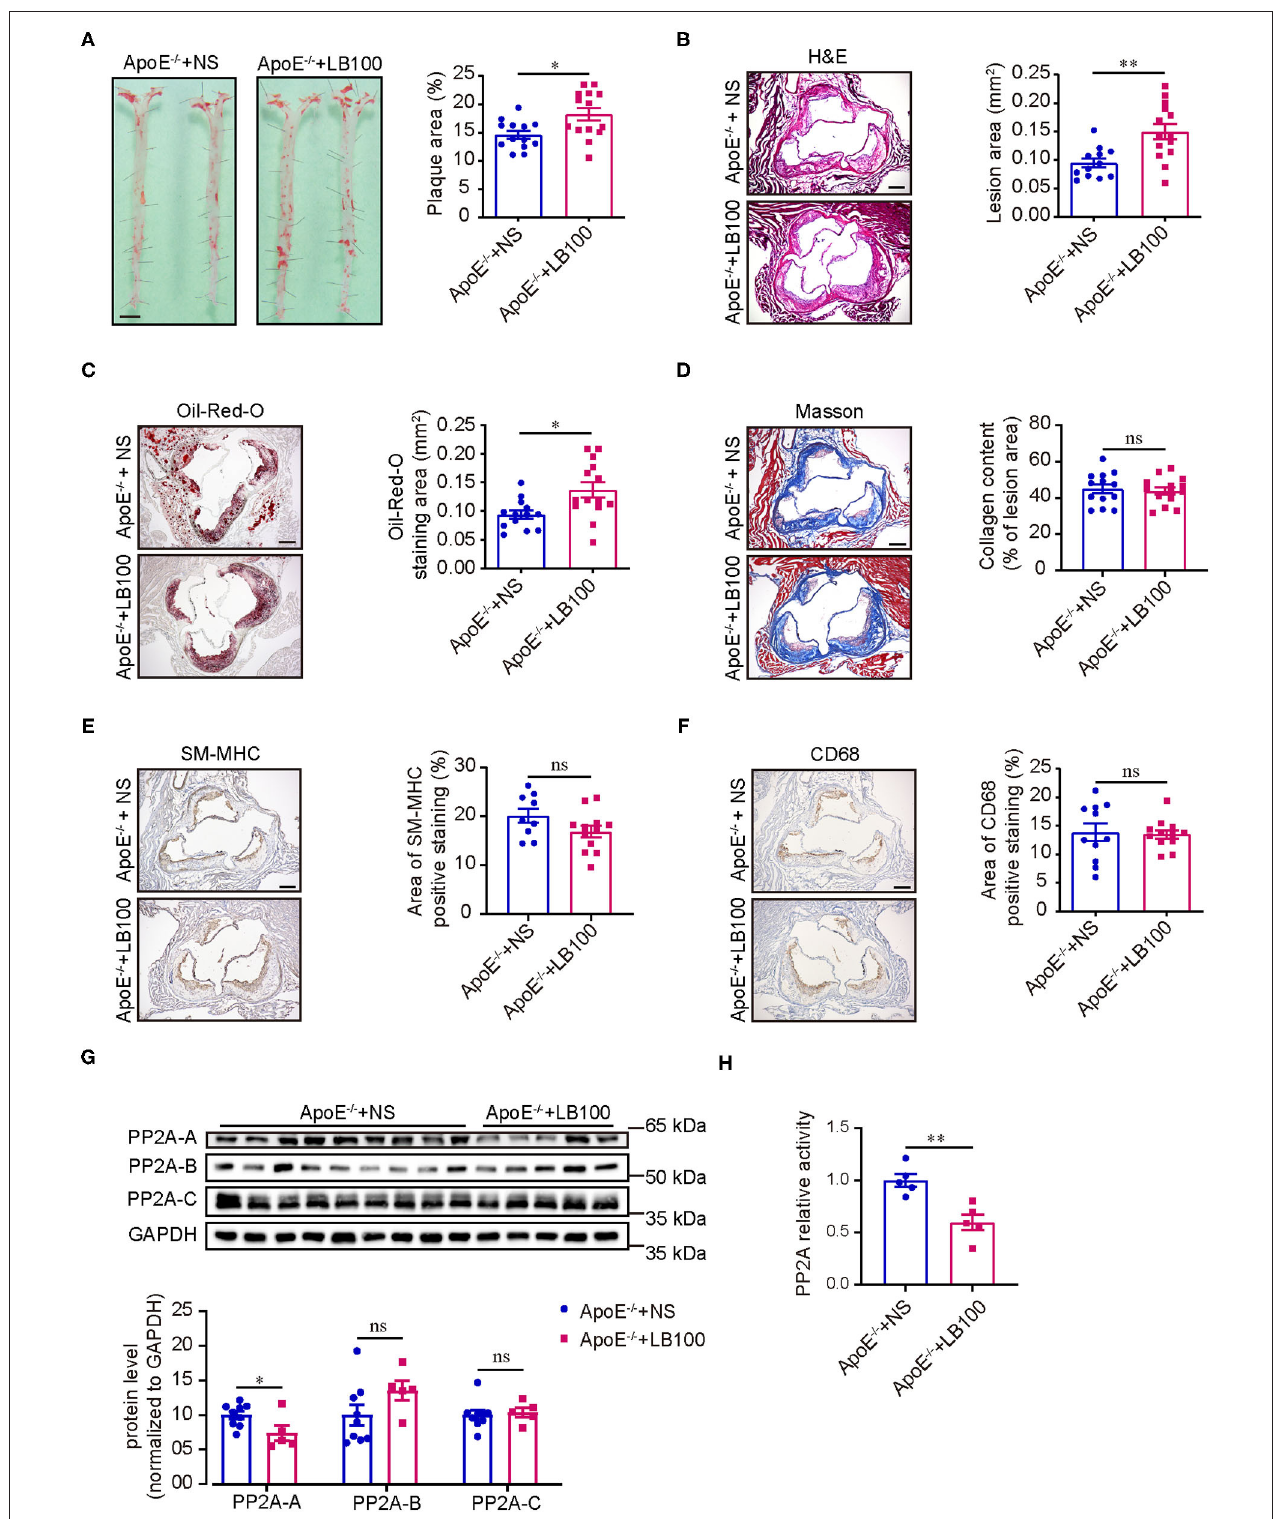
FIGURE 2 | LB100 increased the area of atherosclerotic plaque in ApoE − / − mice. (A) Left panel: representative images of whole aortas stained with Oil-Red-O from ApoE − / − mice with NS or LB100 treatment and 12 weeks of western diet feeding. Bar = 2.5mm. Right panel: quantification of aortic atherosclerotic plaque area ( n = 13–14). (B) Left panel: representative image of aortic root cross sections stained with H & E. Bar = 100 µ m. Right panel: quantification of lesion area in aortic root